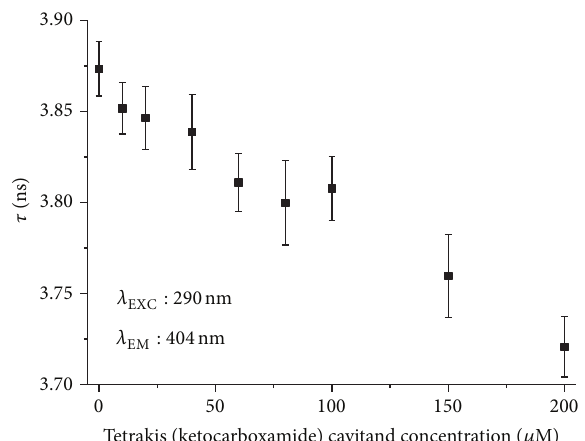
Figure 3: Anthracene fluorescence lifetime in the presence of different concentrations of 1